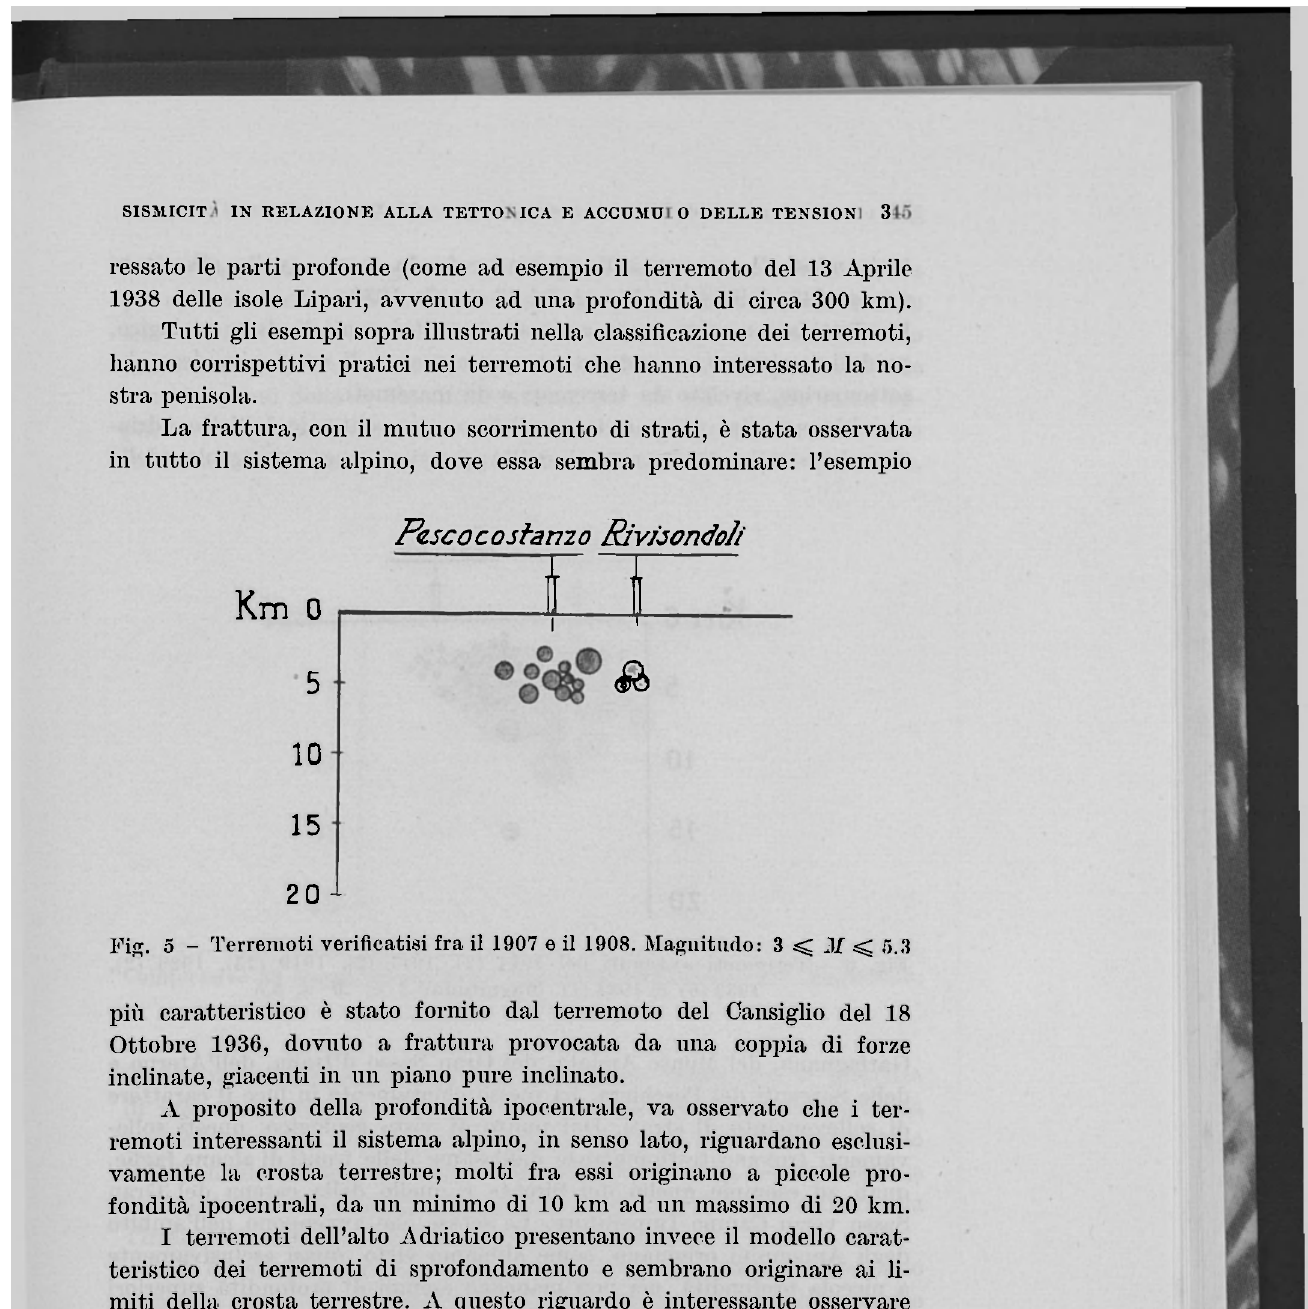
Fig. 5 - Terremoti verificatisi fra il 1907 e il 1908. Magnitudo: 3 ^ M < 5.3 più caratteristico è stato fornito dal terremoto del Cansiglio del .18 Ottobre 1936, dovuto a frattura provocata da una coppia di forze inclinate, giacenti in un piano pure